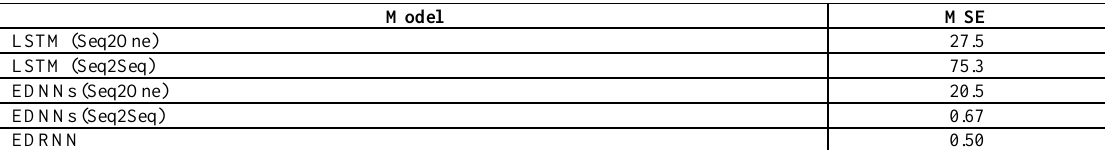
Table 5. MSE results of the proposed model and neural network-based